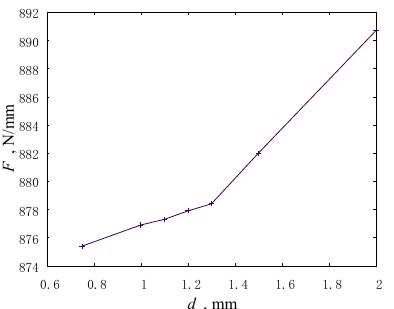
Figure 3. Stiffness of the model knee joint versus the size of discrete elements in the models.